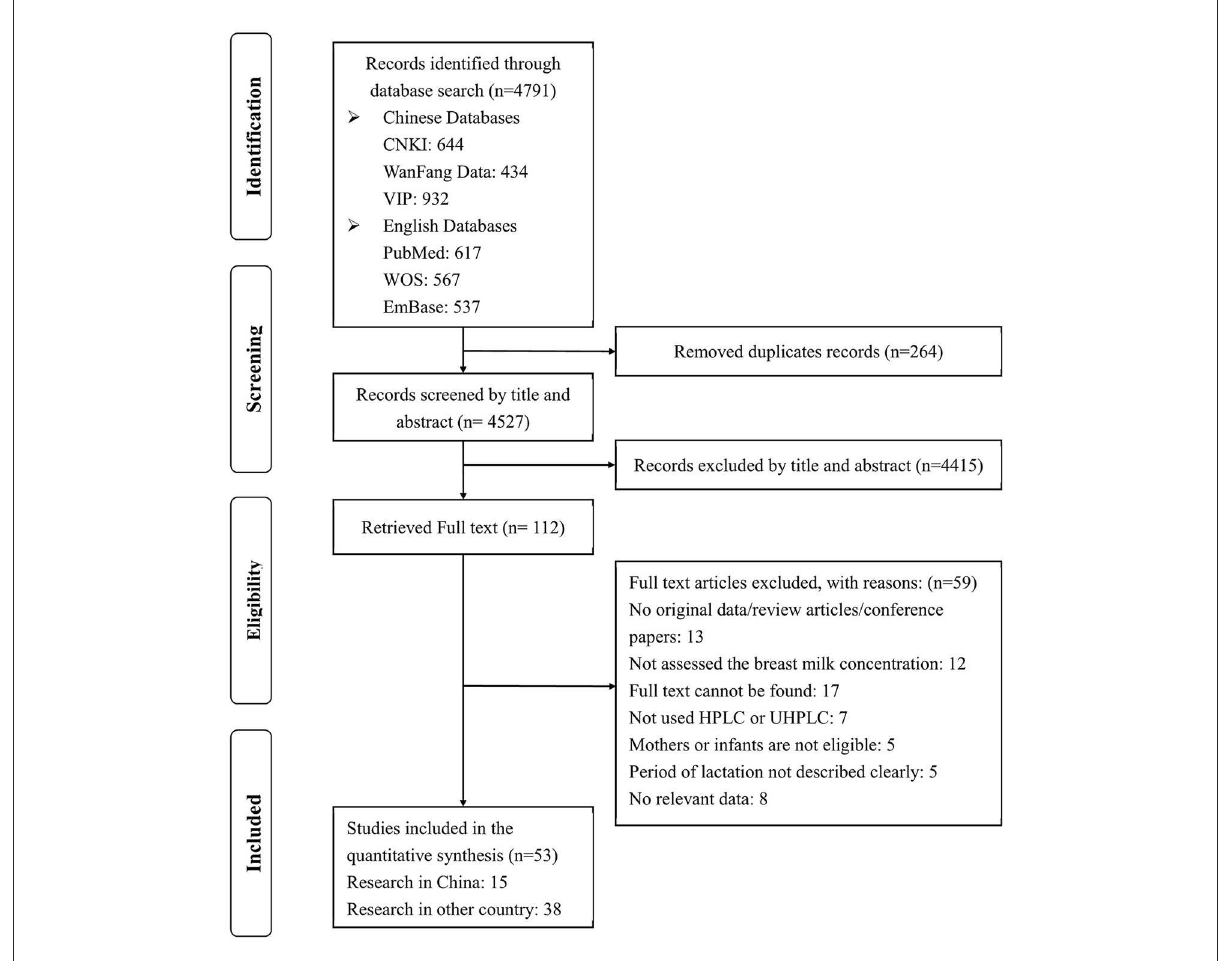
FIGURE1 Study selection